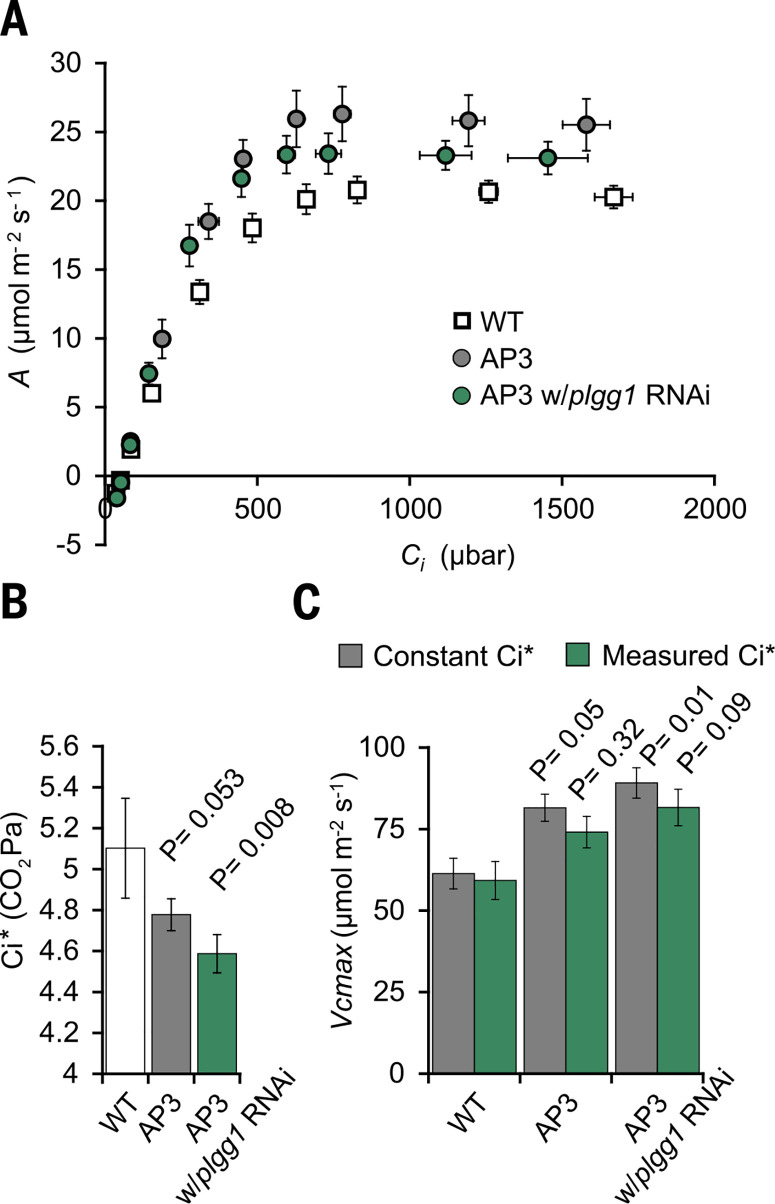
Photosynthetic efficiency of greenhouse-grown plants. Data are the combined result of three independent transformants (hereafter referred to as combined) with and without PLGG1 RNAi. (A) CO2 assimilation based on intercellular [CO2] (Ci). (B) Combined apparent CO2 compensation point: Ci* calculated using the common intercept method and slope regression (29). (C) Combined maximum rate of RuBisCO carboxylation (Vcmax). Vcmax values are presented at 25°C and modeled from photosynthetic response under changing CO2 concentration. Gray bars indicate constant Ci*; green bars indicate derived values based on measured Ci*. Error bars indicate SEM. P values for statistical comparison to WT based on one-way ANOVA are given.